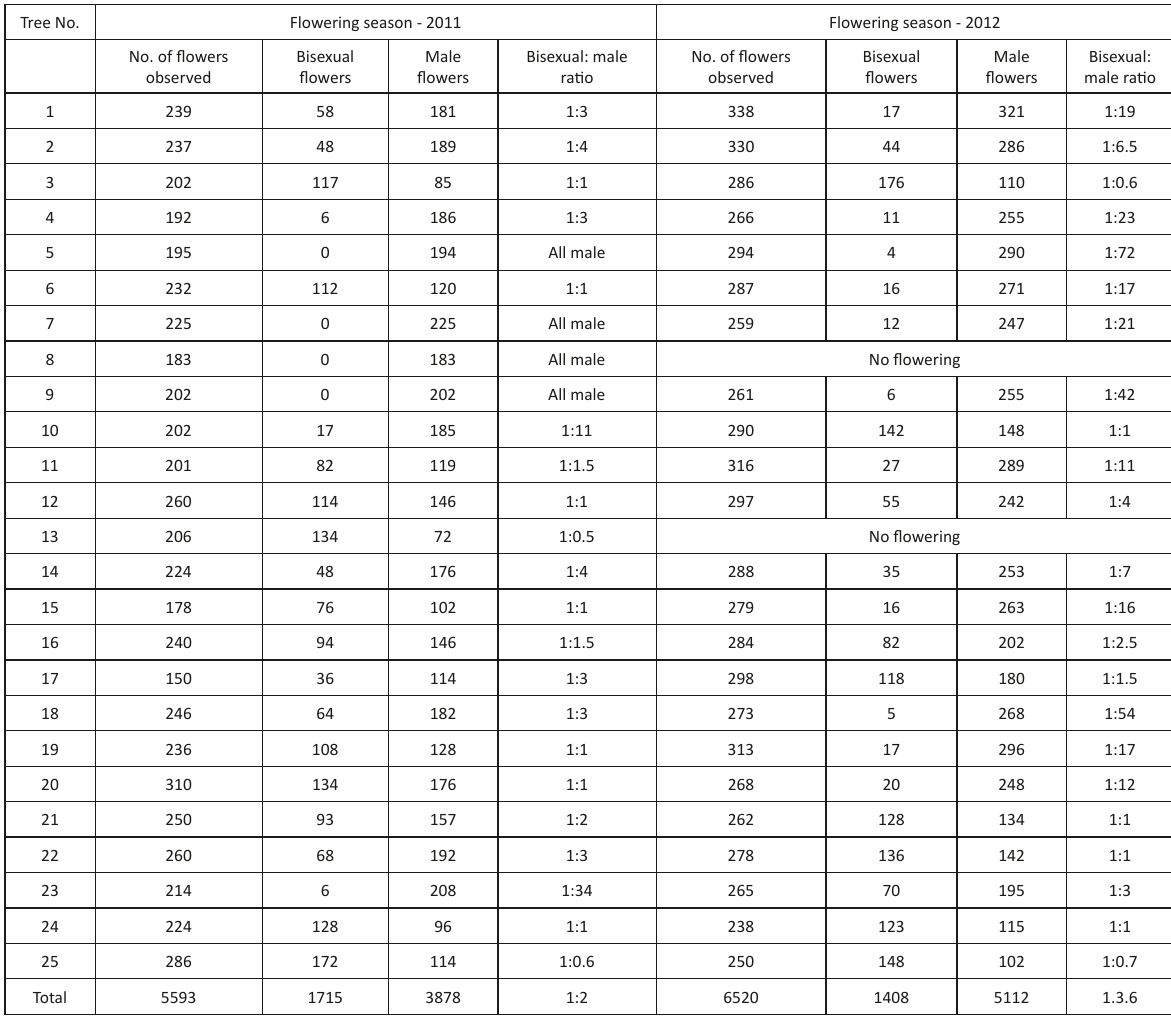
No. of inflorescences observed per tree: 10; the values are rounded off to the nearest point for sex